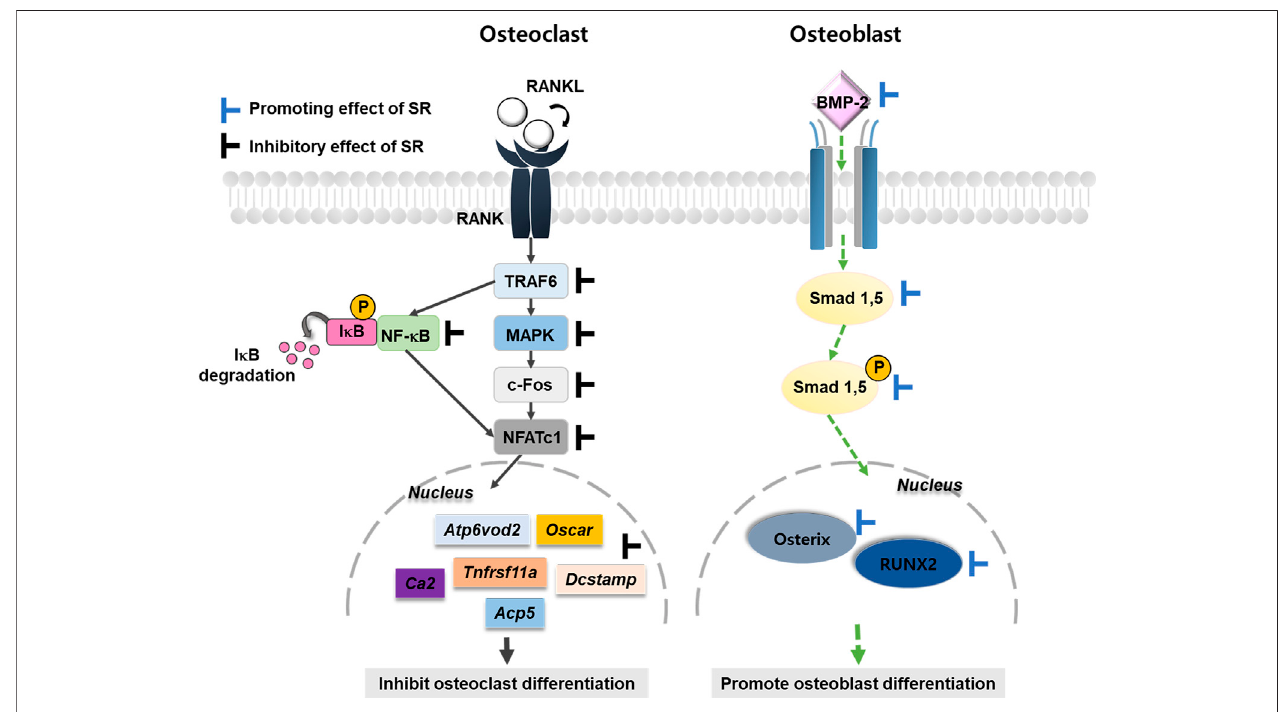
FIGURE 13 | Schematic diagram of SR in bone